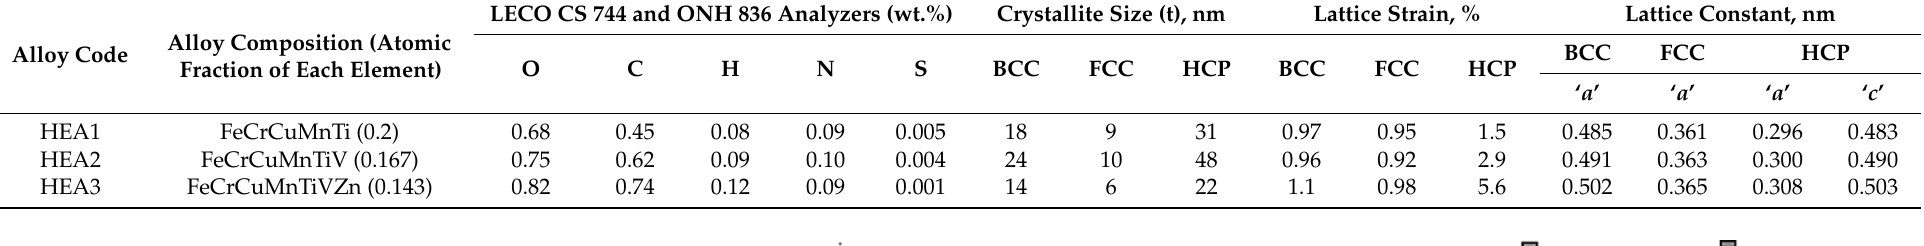
Table 1. Chemical composition, the crystallite size, lattice strain, and lattice constant of three developed high entropy alloys. Alloy Composition (Atomic Alloy Code Fraction of Each Element)